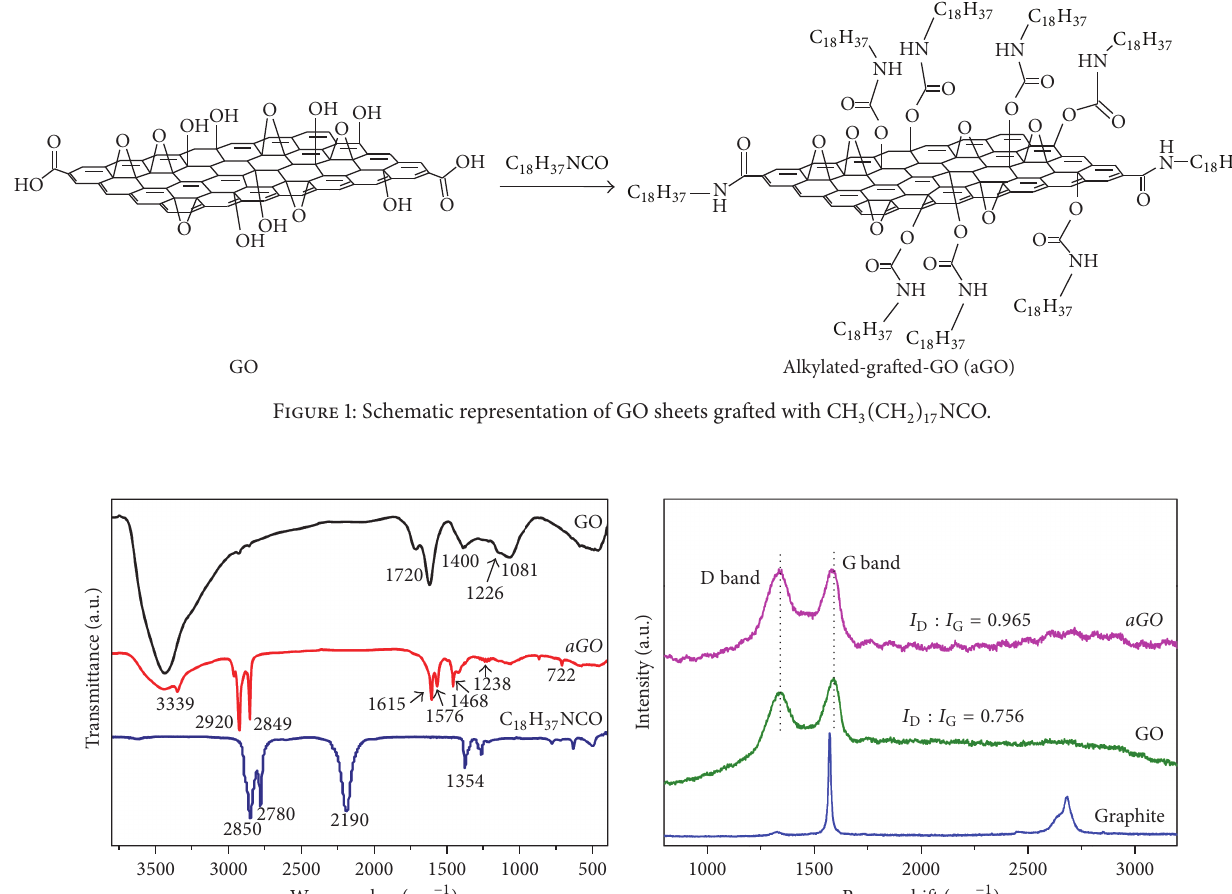
fixed and the upper grip rose at a rate of 5 mm/min. The gauge length was 20